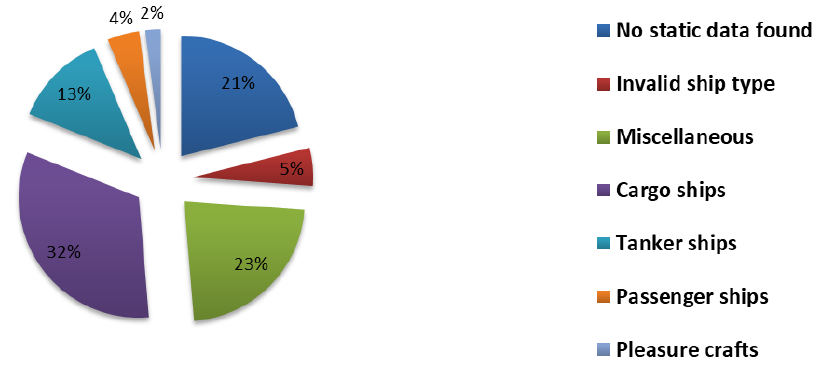
Figure 8. Breakdown of AIS dataset by ship type.